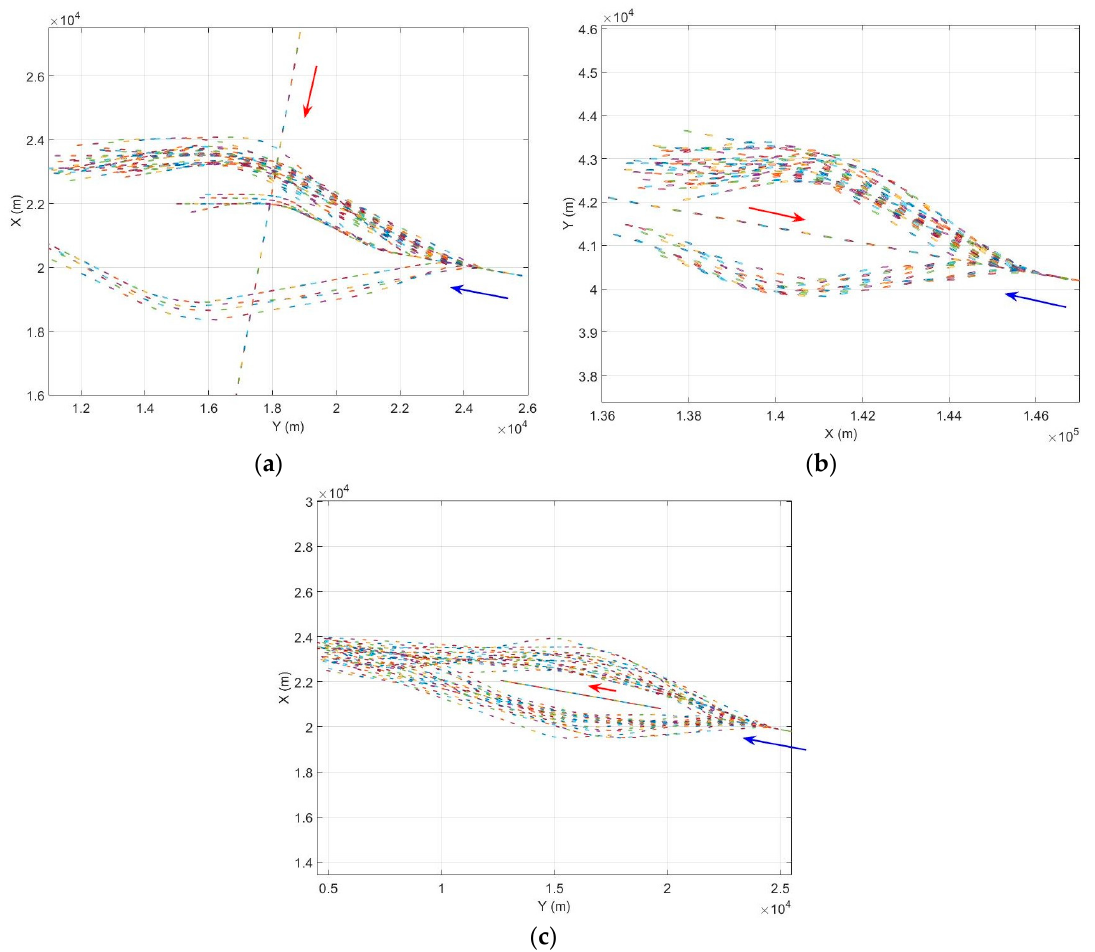
Figure 4. True trajectories for “medium” ship in selected scenarios: ( a ) “Crossing”; ( b ) “Head-on” and ( c ) “Overtaking”.